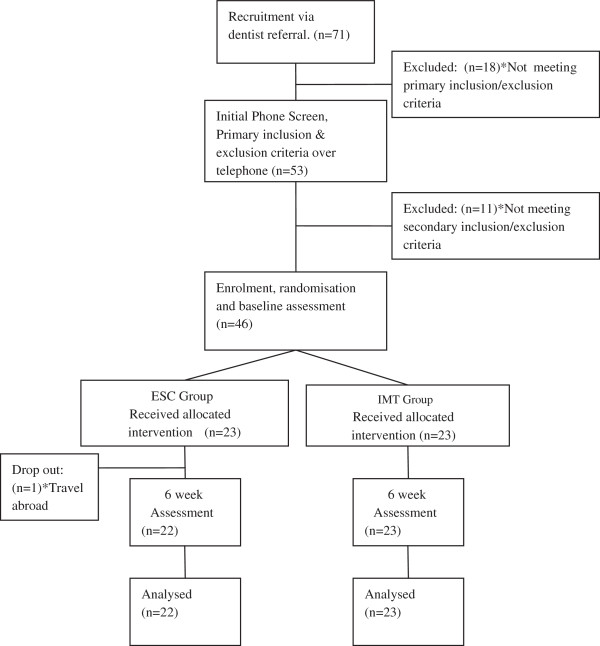
Study flow-chart.